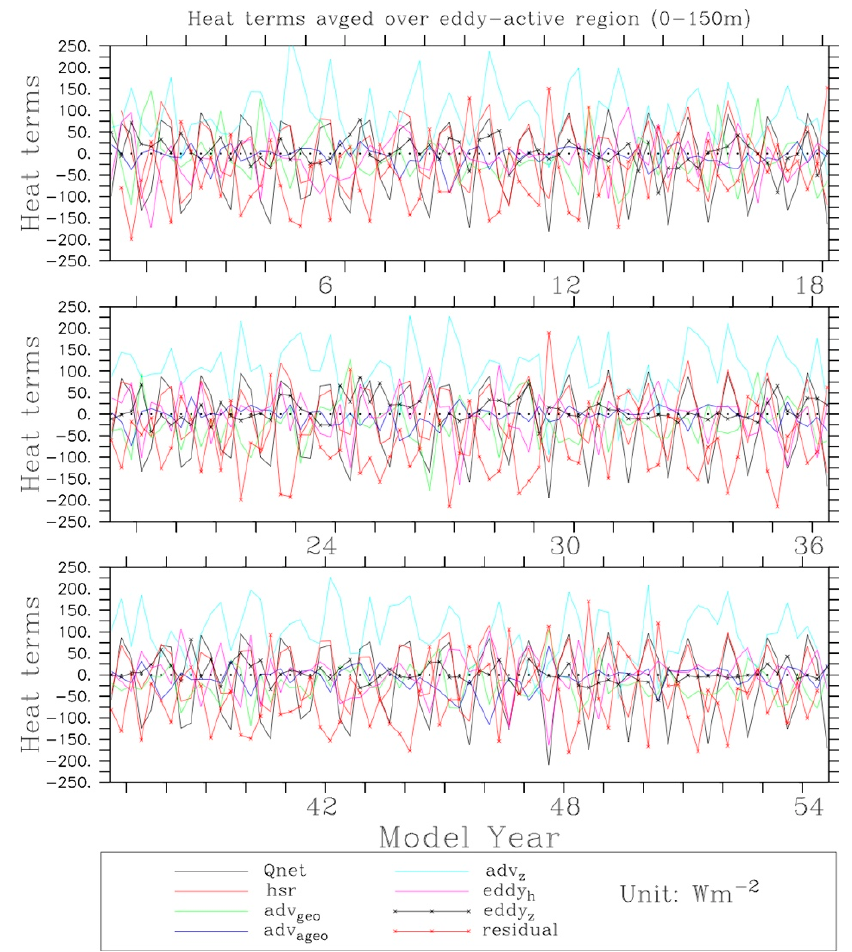
Figure 11. Same as Figure 10 except for the upper 150 m ocean . Table 2. Mean ± std of ocean heat budget terms (hsr = Qnet + adv h + adv z + eddy h + eddy z + residual in Equation (2)) for the 0–150 m layers averaged over an eddy-active region (EDDY in short) where the observed surface eddy kinetic energy is larger than 200 cm 2 s − 2 based on surface AVISO data, which is illustrated in a region enclosed by bold black curves in Figure 2, and over the western GOM (WGOM in short) (98°W–88°W,18°N–30°N). Only the heat terms in the region where waters are shallower than 150 m are computed. Note that adv h = adv geo + adv ageo . (Units: W m − 2 .) Abbreviations: hsr: heat storage rate; Qnet: net surface heat flux; adv h : horizontal heat advection by seasonal mean current; adv z : vertical heat advection by seasonal mean current; adv geo : horizontal heat advection by seasonal mean geostrophic current; adv ageo : horizontal heat advection by seasonal mean ageo- strophic current; eddy h : horizontal eddy heat flux convergence; eddy z : vertical eddy heat flux con- vergence. Regions